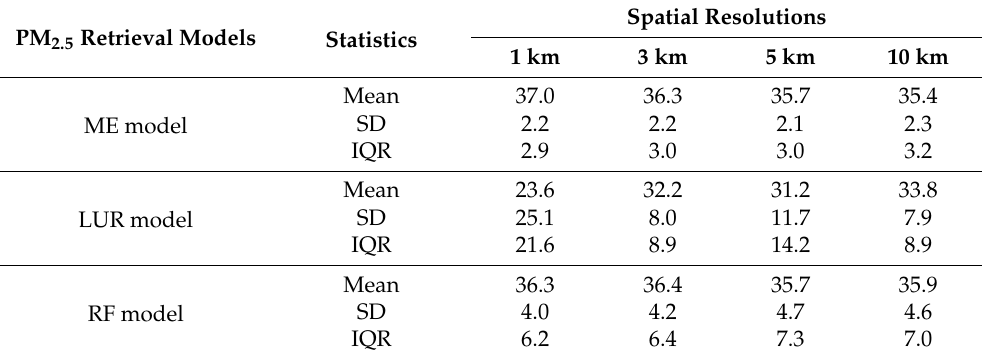
Table 2. Main statistics of annual (2020) PM 2.5 concentration ( µ g/m 3 ) estimated by the mixed effects (ME), the land-use regression (LUR) and the Random Forest (RF) models. PM 2.5 Retrieval